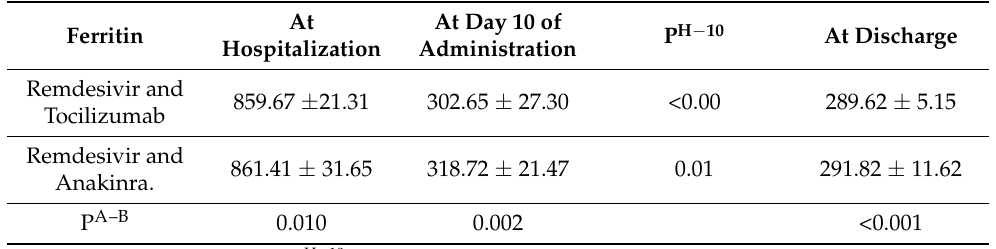
At At Day 10 of Hospitalization